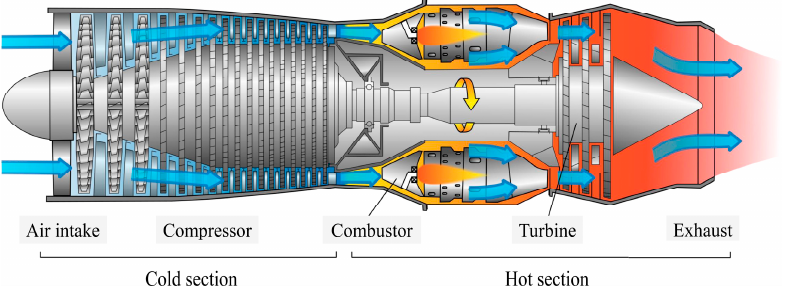
Figure 1. Sectional view of a turbojet engine. Adapted with permission from [2]. Licensed under a